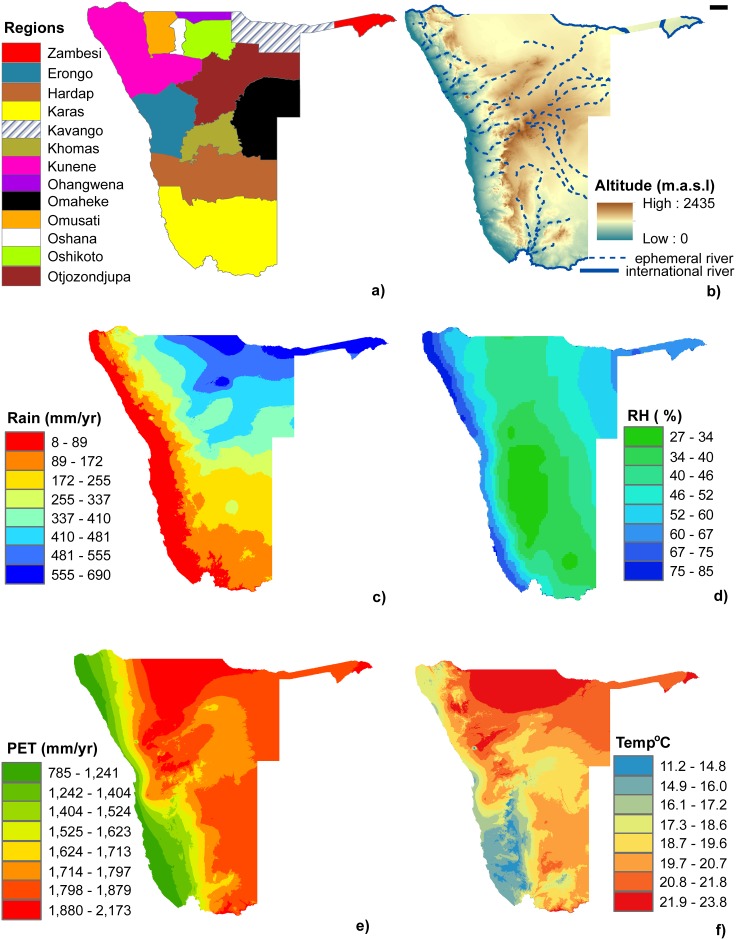
Geographical and meteorological data for Namibia.(a) Namibia’s administrative regions, (b) digital elevation model (DEM), (c) mean annual rainfall, (d) mean annual relative humidity (RH%), (e) mean annual potential evapotranspiration (PET) and (f) mean annual temperature.